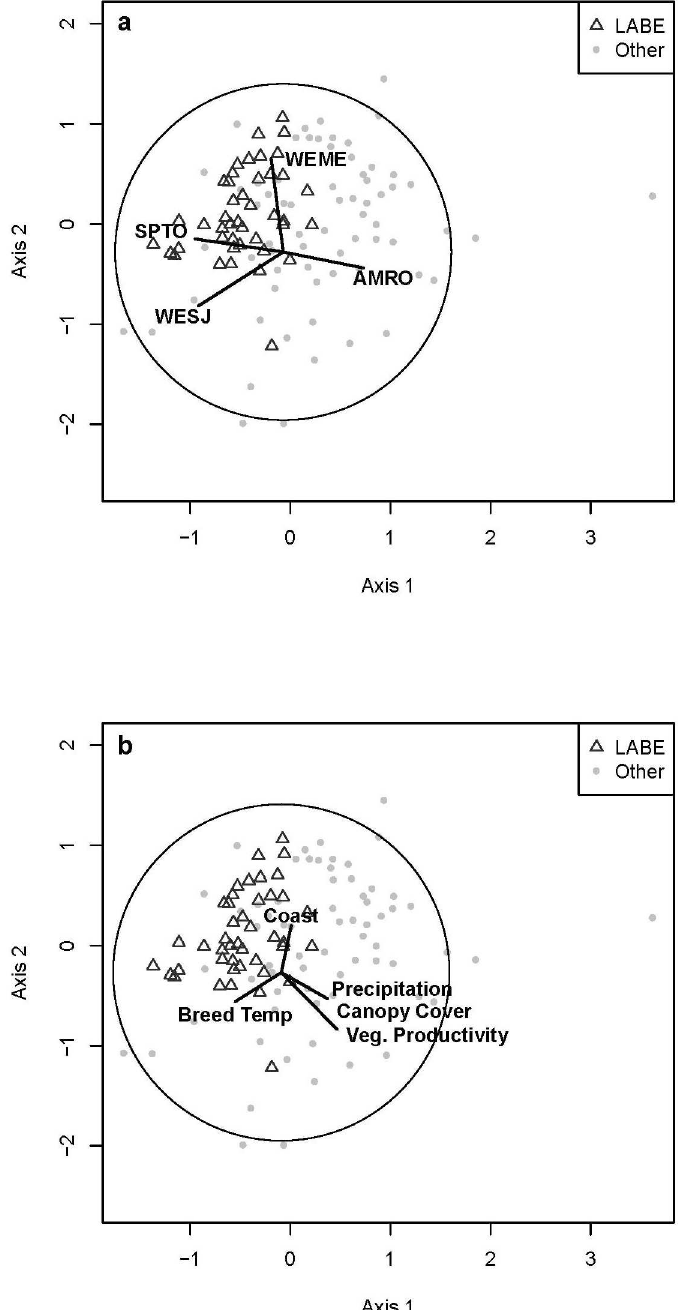
Fig 5. Bird Communities and Environmental Variables in Shrubland Habitat. Relationship of individual bird sites (displayed by park unit) identifiedas shrublandhabitat (see text) using Non-metric Multidimensional Scaling. Biplots are direction and relative strength of Pearson correlationcoefficients (the circle indicates a correlationof 1) between bird sites and (A) underlyingbird species with a rho of > 0.5 and (B) environmental variables that maximized the overall correlationthrough BIOENV (Table 4). See S1 Table for bird codes and S2 Table for definitions and abbreviations of environmental